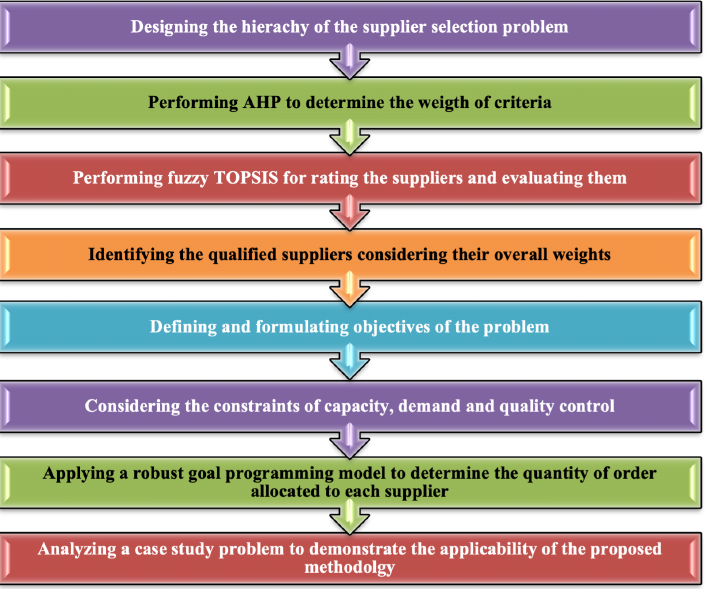
Figure 1. A solution procedure for the proposed model of supplier selection and order